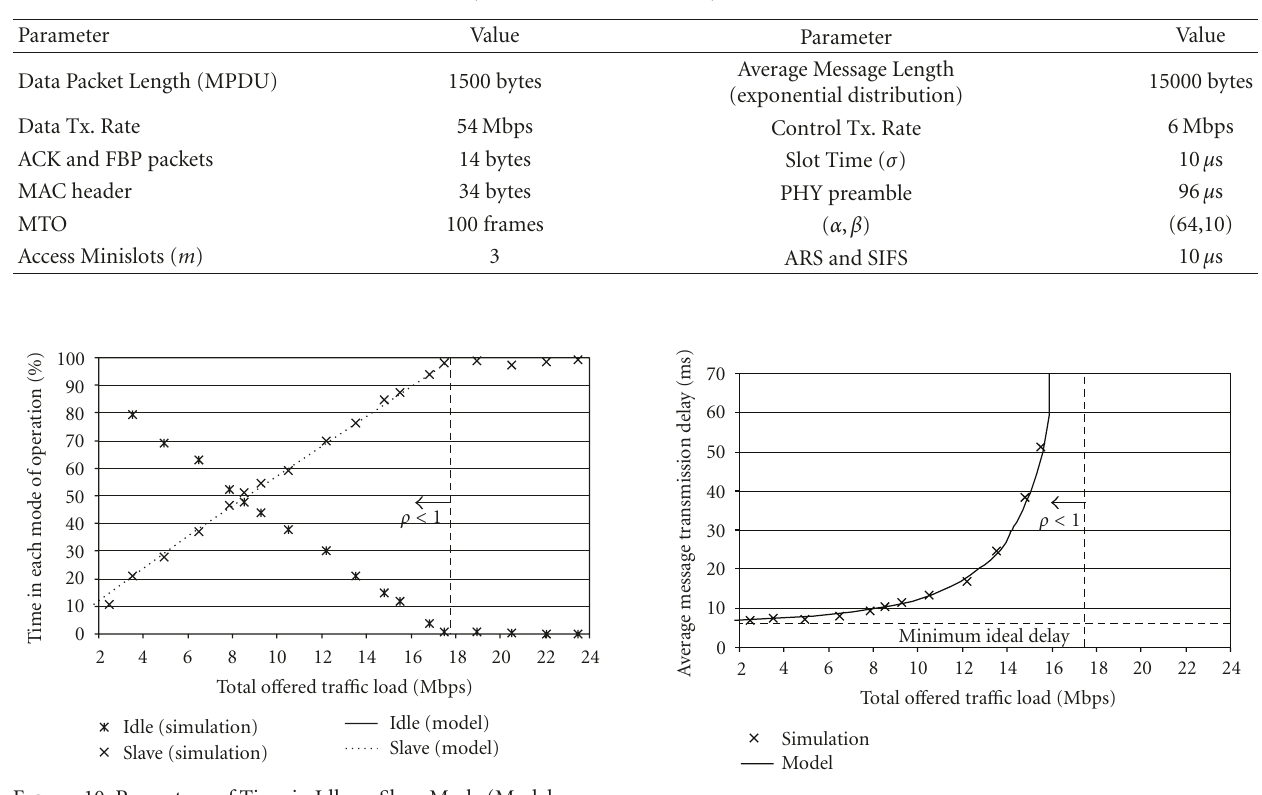
Table 1: System Parameters for Analysis and Simulation.